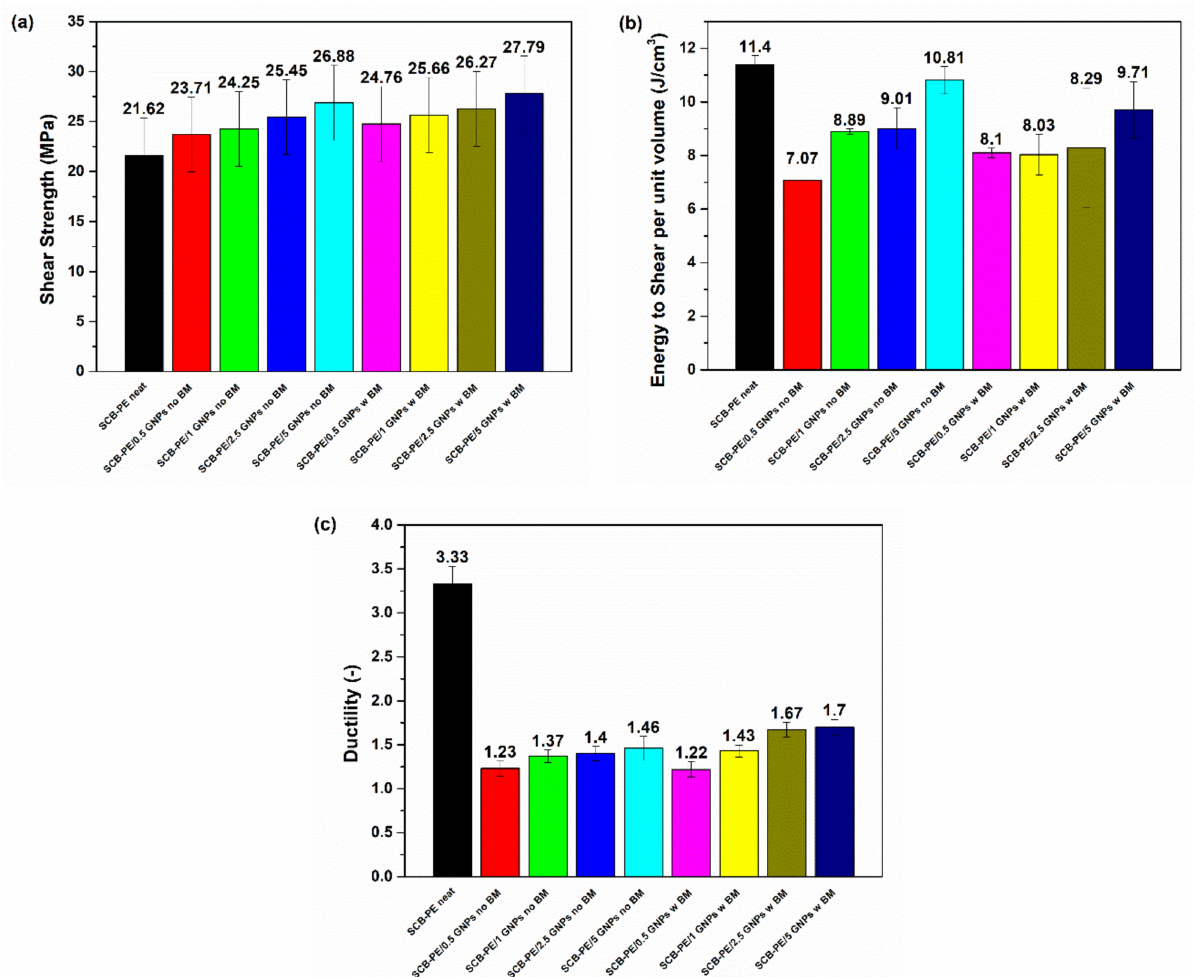
Figure 6. ( a ) Bar chart comparing shear strength measured from mechanical tests, ( b ) bar chart comparing energy to shear measured for all SCB-PE specimens, and ( c ) ductility of the